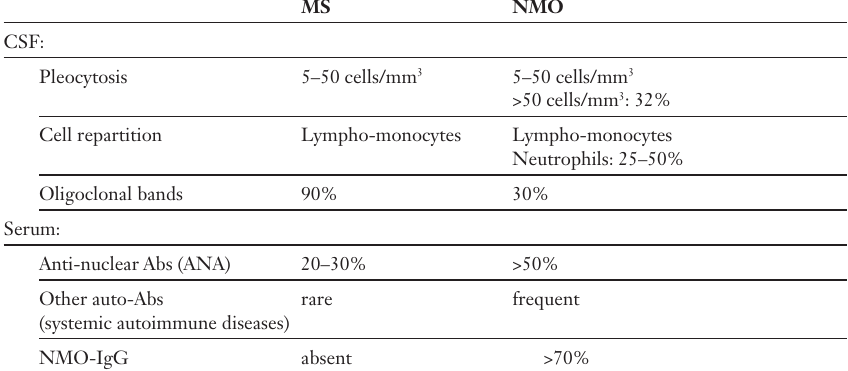
Biological character- istics of MS and NMO [104, 108,